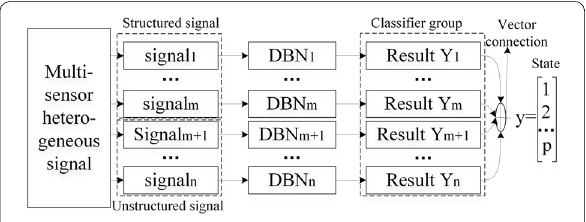
Figure 16 Fault diagnosis process of DBN based on multi- source heterogeneous information fusion